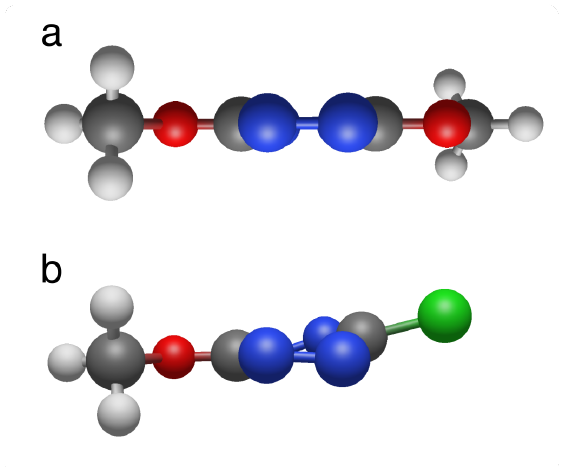
Figure 4. S 1 / T 2 minimum energy crossing points of C 1 C 1 ( a ) and of ClC 1 ( b